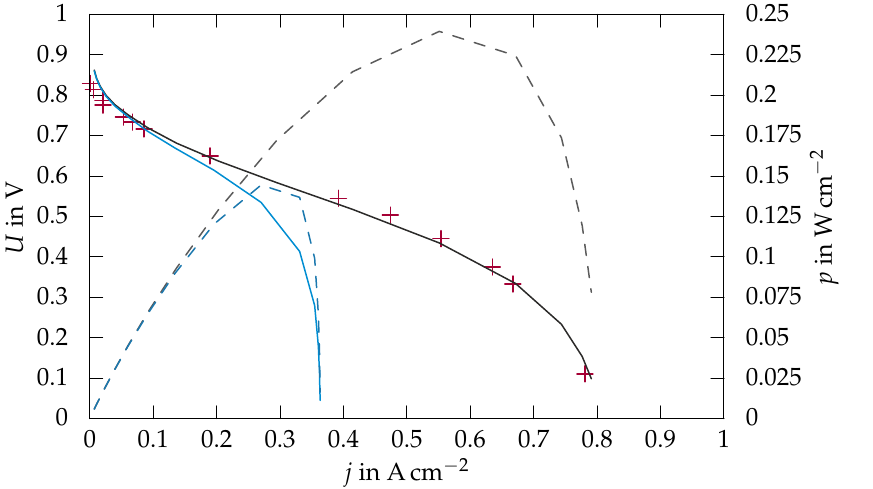
Figure 9. Polarisation curves for the parameter variation of the platinum to electrolyte ratio PtE = 21 − 28% for z CL = 36µm.